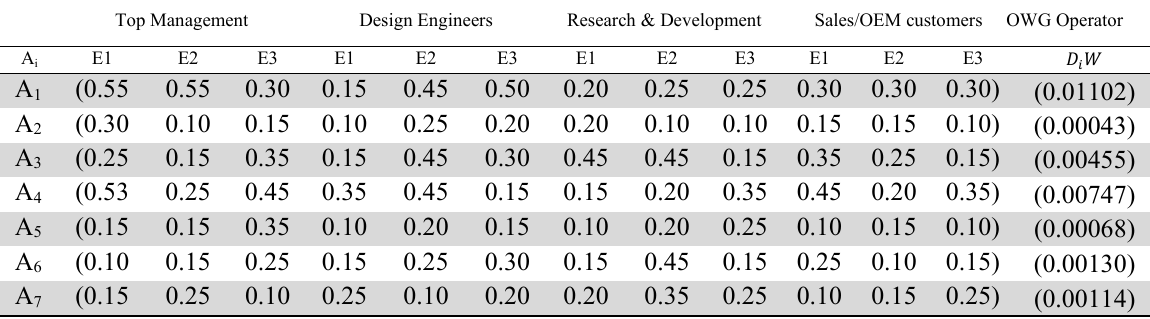
Performance survey results for the relative importance of the lean